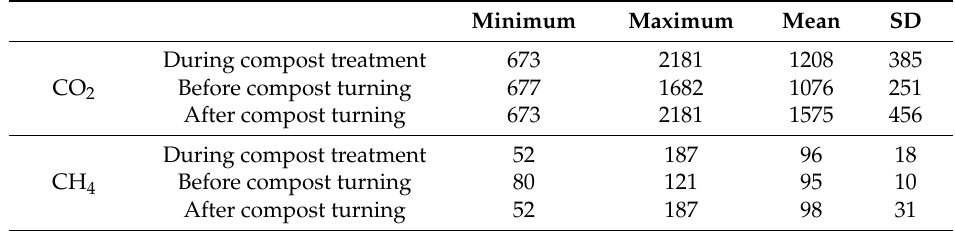
Table 5. Concentration distribution of carbon dioxide and methane according to the composting process of swine